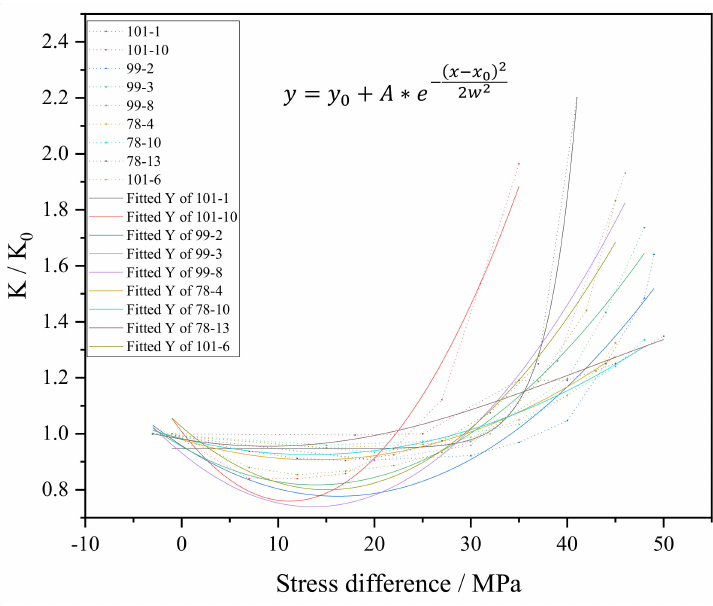
Figure 10. Fitting of the relative permeability with the stress difference. Table 3. Core data from the cracks with different degrees of development (confining pressure was 3 MPa and axial pressure was 0.7